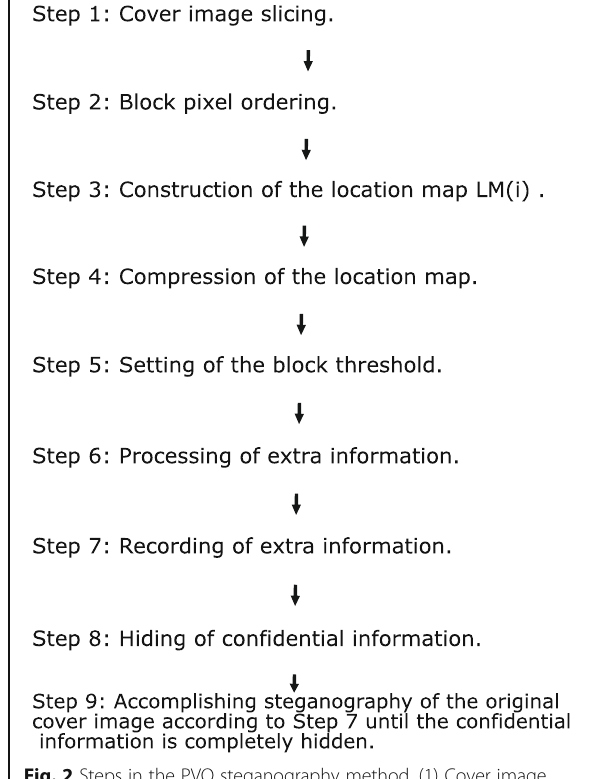
Fig. 2 Steps in the PVO steganography method. (1) Cover image slicing. (2) Block pixel ordering. (3) Construction of the location map LM (i) . (4) Compression of the location map. (5) Setting of the block threshold. (6) Processing of extra information. (7) Recording of extra information. (8) Hiding of confidential information.